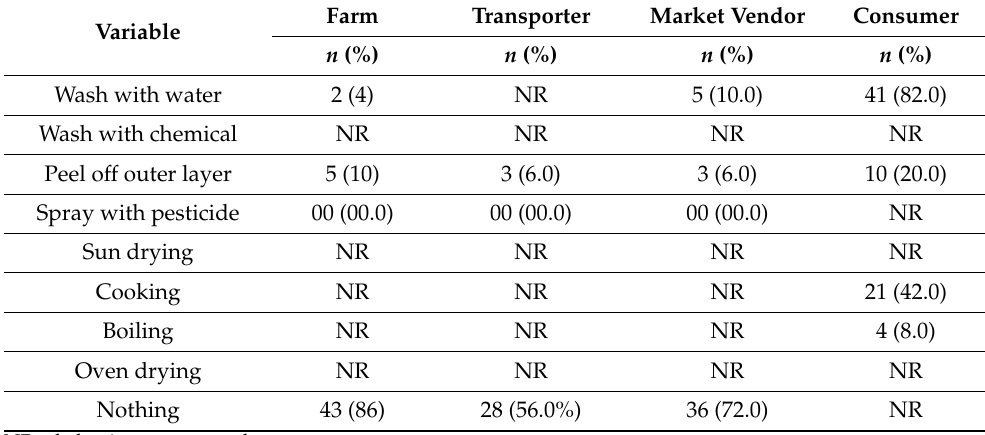
Table 4. Handling and processing methods used by stakeholders along the chain from farm to fork n = 50. Farm Transporter Market Vendor Consumer Variable n (%) Wash with